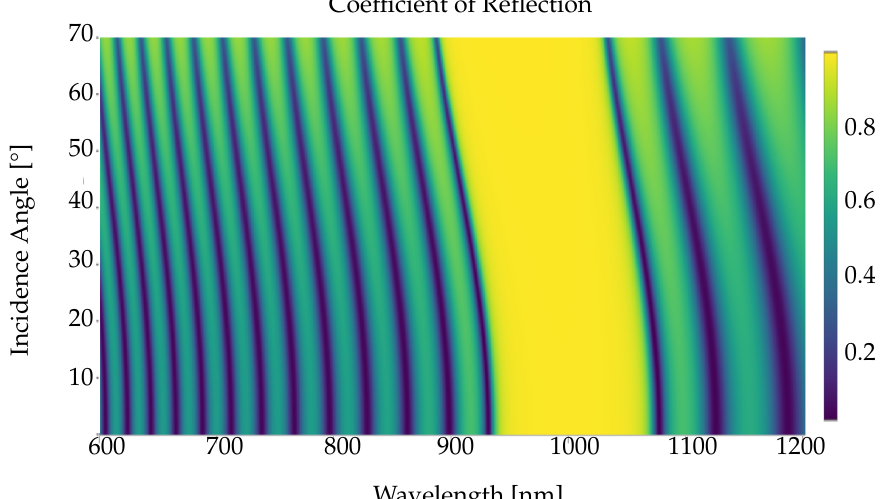
Figure 10. Reflection dispersion (reflectivity vs. spectrum and incidence angle) for a quarter-wave stack (Bragg mirror) made of 20 alternating gallium arsenide (GaAs) and aluminum arsenide (AlAs) films, with refractive indices n h = 3.49 and n l = 2.95, respectively, and layer thicknesses t h = 71.6nm and t l = 84.7nm, respectively. Our calculations reveal an angle-robust stop band between 930nm and 1030nm incident